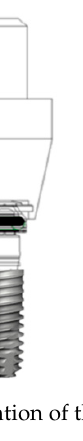
Figure 1. The five different implant attachment systems used in this study. Custom-made titanium-alloy jigs, attachment replacements, and implant fixture-tightened attachment abutments. From left to right: MAG, ORI, EZL, LOC, and KER.